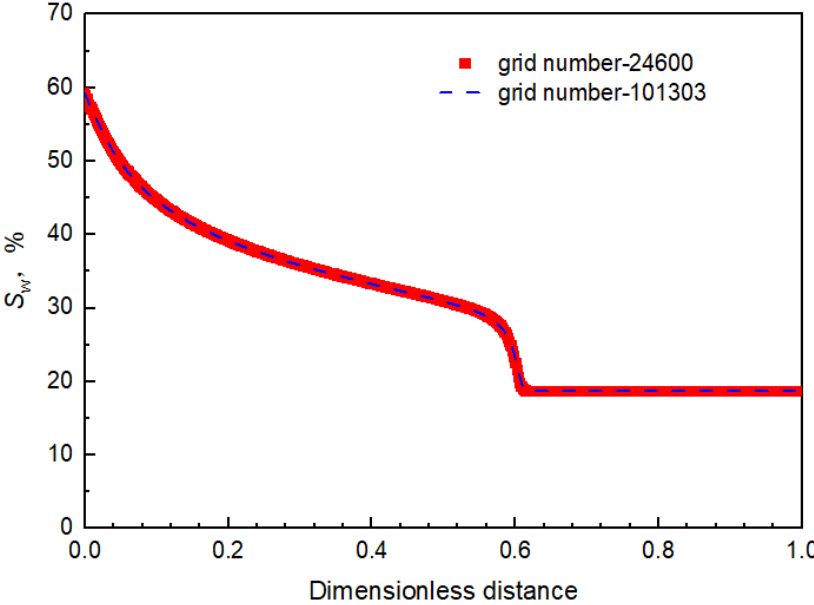
Figure 9. Comparison of water saturation along the flow under different densified grid conditions.